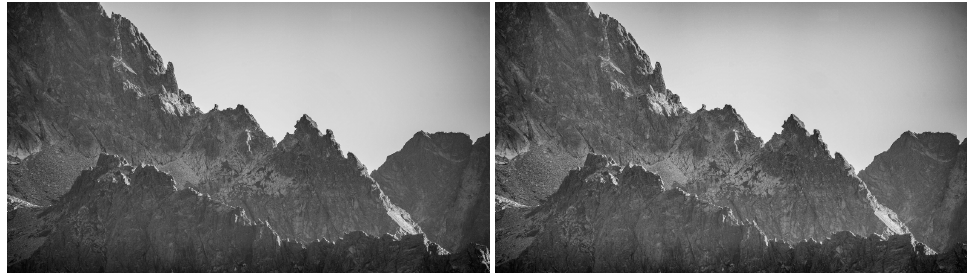
Figure 15. Comparison of output images obtained with the “classic” ( left ) and OpenCV ( right ) redistribution. In this case, the redistribution from OpenCV results in a brighter